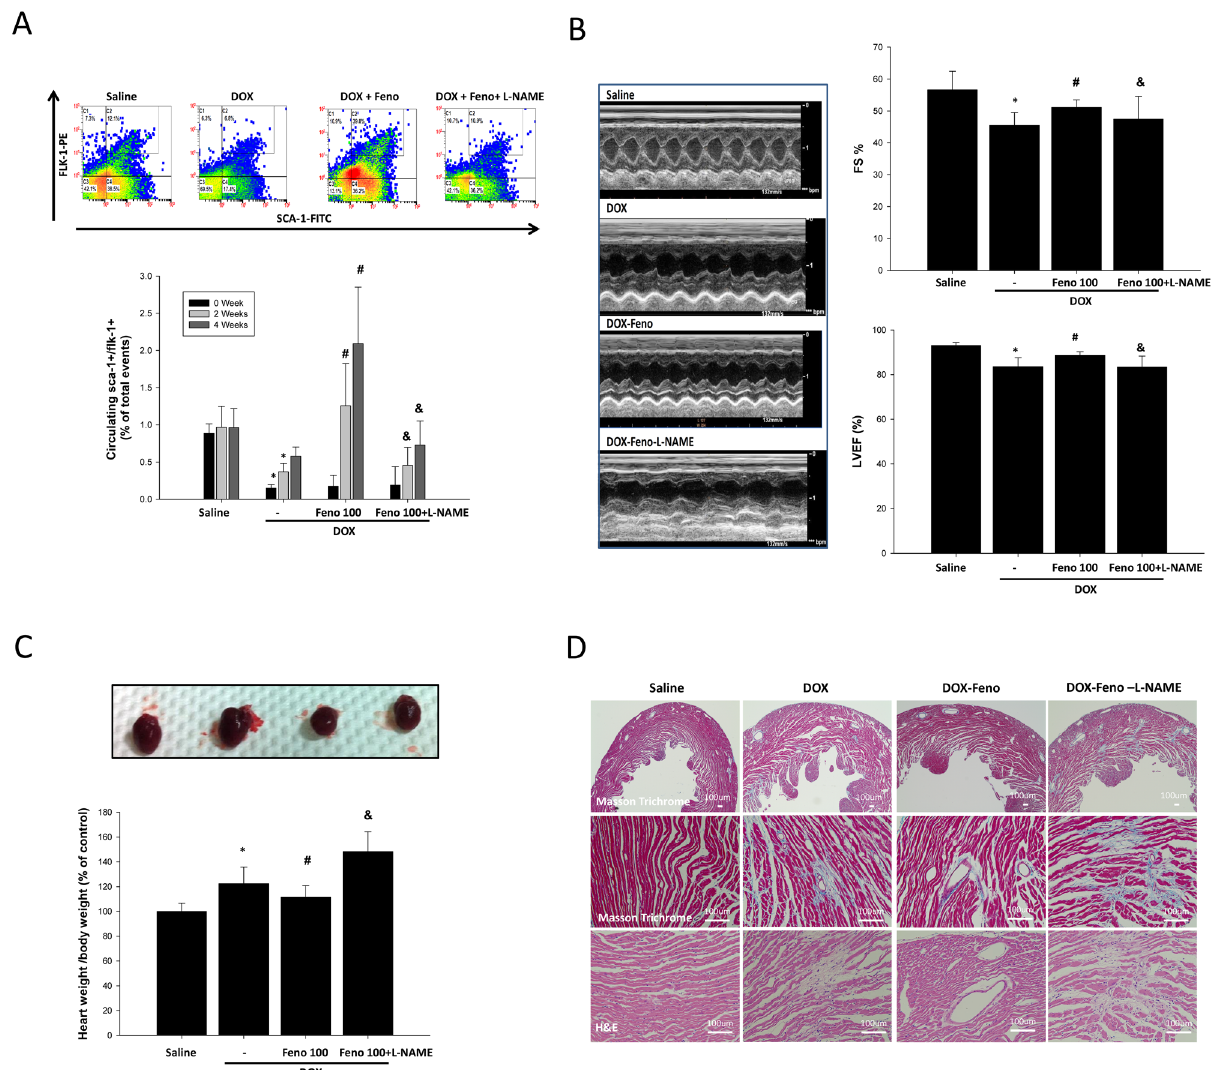
Figure 3. Effect of fenofibrate on cardiac dysfunction in doxorubicin-treated wild-type FBV mice. ( A ) FBV mice after the administration of saline, fenofibrate, or fenofibrate + L-NAME after DOX treatment. Fenofibrate significantly improved EPC mobilization after DOX treatment, and fenofibrate reversed the decrease in EPC cell numbers with L-NAME treatment. ( B ) M-mode echocardiographic images of mice treated with saline, fenofibrate, and fenofibrate + L-NAME after DOX treatment. Quantitative analysis of LVFS in mice treated with saline, fenofibrate, and fenofibrate + L-NAME after DOX treatment. ( C ) Heart weights and body weight ratios of mice treated with saline, fenofibrate, and fenofibrate + L-NAME after DOX treatment. * p < 0.05 versus saline; # p < 0.05 versus DOX alone; and p < 0.05 versus DOX + fenofibrate. One-way ANOVA. ( D ) Masson’s trichrome staining was performed on heart sections from each of the groups: fenofibrate and fenofibrate + L-NAME after DOX treatment, N = 3–4/group. Experiments were n =